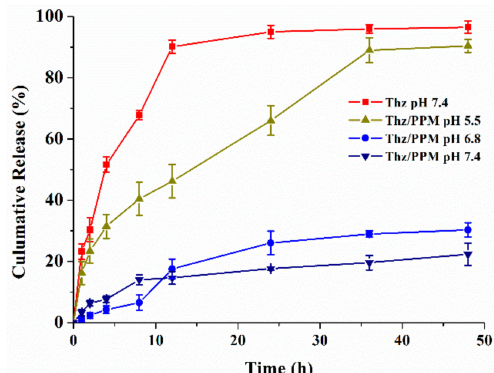
Figure 4. Release profile of Thz from Thz / PPM under di ff erent pH values (7.4, 6.8, and 5.0) in vitro ( n = 3).